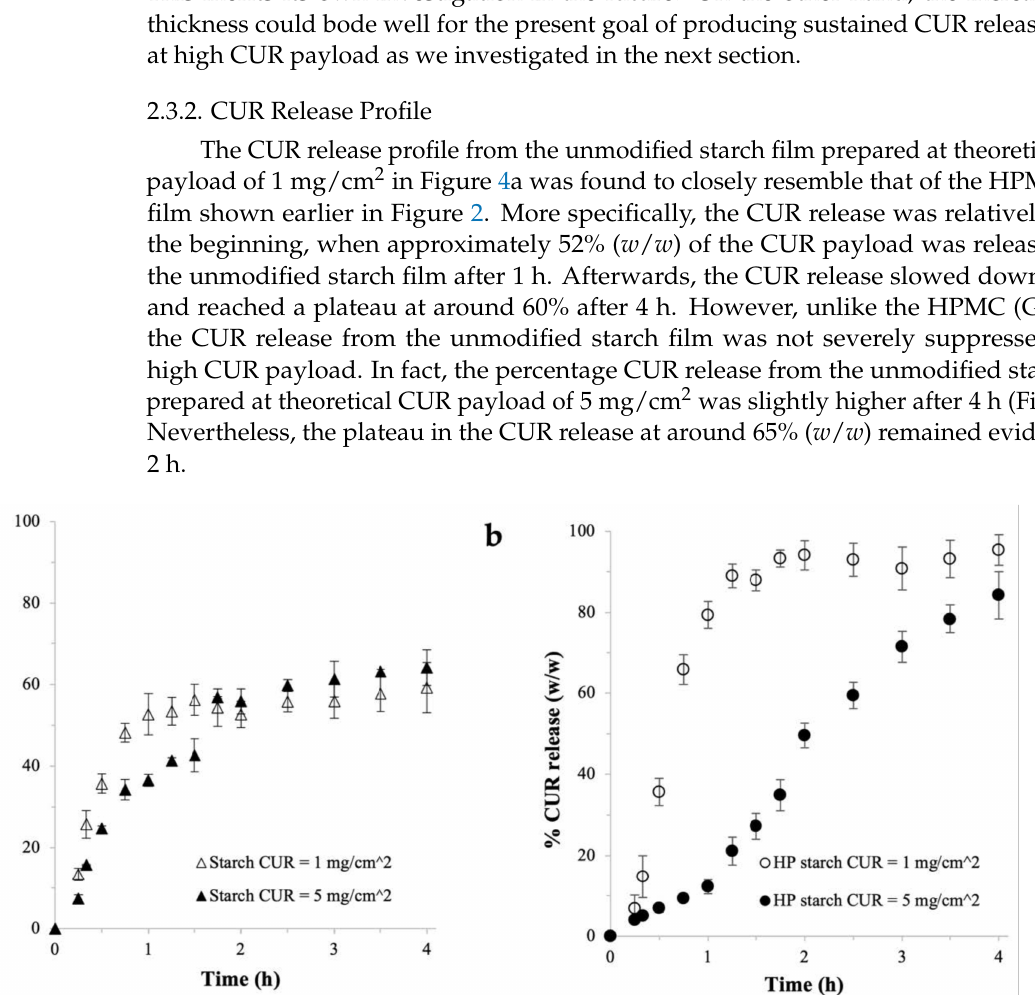
Figure 4. CUR release from ( a ) unmodified starch and ( b ) HP starch films ( n = 6, error bars represent the standard